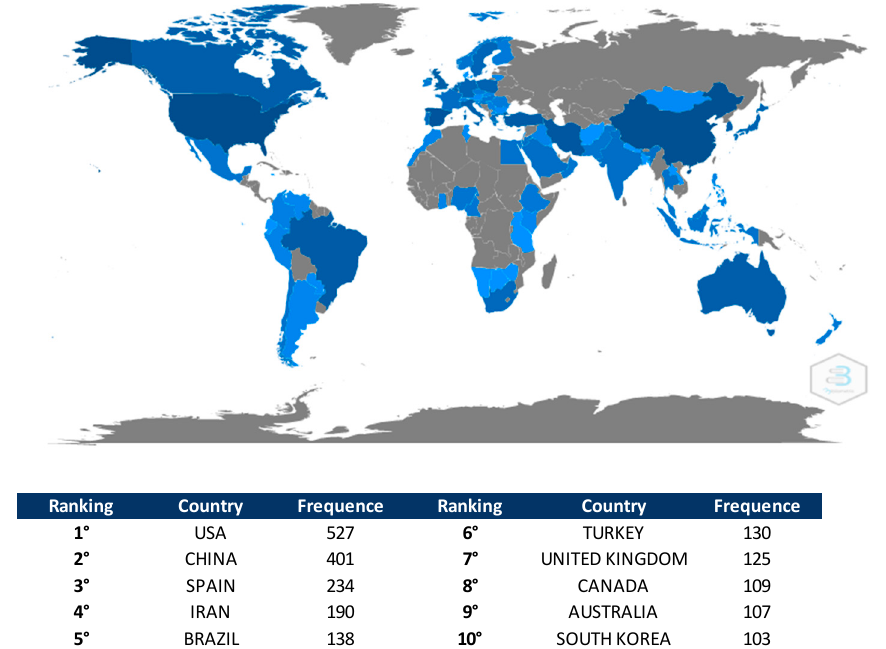
Figure 5. Scientific production by country.